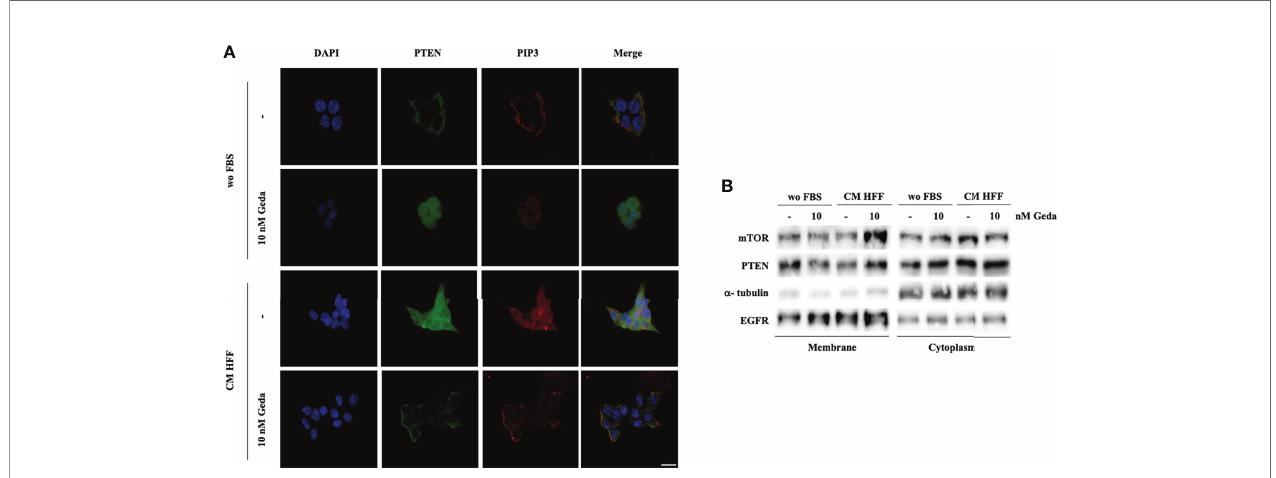
FIGURE 4 | Fibroblast-derived CM induces the reduction of PTEN activity and its re-distribution in the cell. (A) Direct immuno fl uorescence analysis of cellular localization of PTEN (green) and PIP3 (red). Nuclear staining was evaluated with DAPI in HCT116 Parental cells in both wo FBS and HFF CM, in absence or presence of 10 nM Geda. Results of a representative experiment out of three independent experiments performed are shown. Microphotographs were taken at ×63 magni fi cation. Scale bar 50 m m. (B) HCT116 Parental cell line were treated with 10 nM of Geda in wo FBS and HFF-CM conditions. Membrane and cytoplasmic fractions of cell line were isolated; molecular differences were analyzed by Western Blotting using speci fi c antibodies (EGFR and a -tubulin are shown as protein loading and blotting control for membrane and cytoplasmic extract, respectively). Results of a representative experiment out of three independent experiments performed are